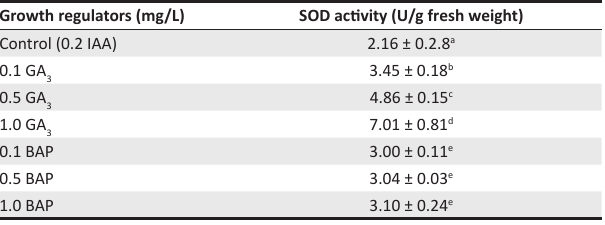
TABLE 5: Effect of different concentrations of gibberellic acid and benzyl aminopurine in combination with indole acetic acid in Murashige and Skoog medium on superoxide dismutase activity in O. gratissimum explants after 28 days of culture. Growth regulators (mg/L)